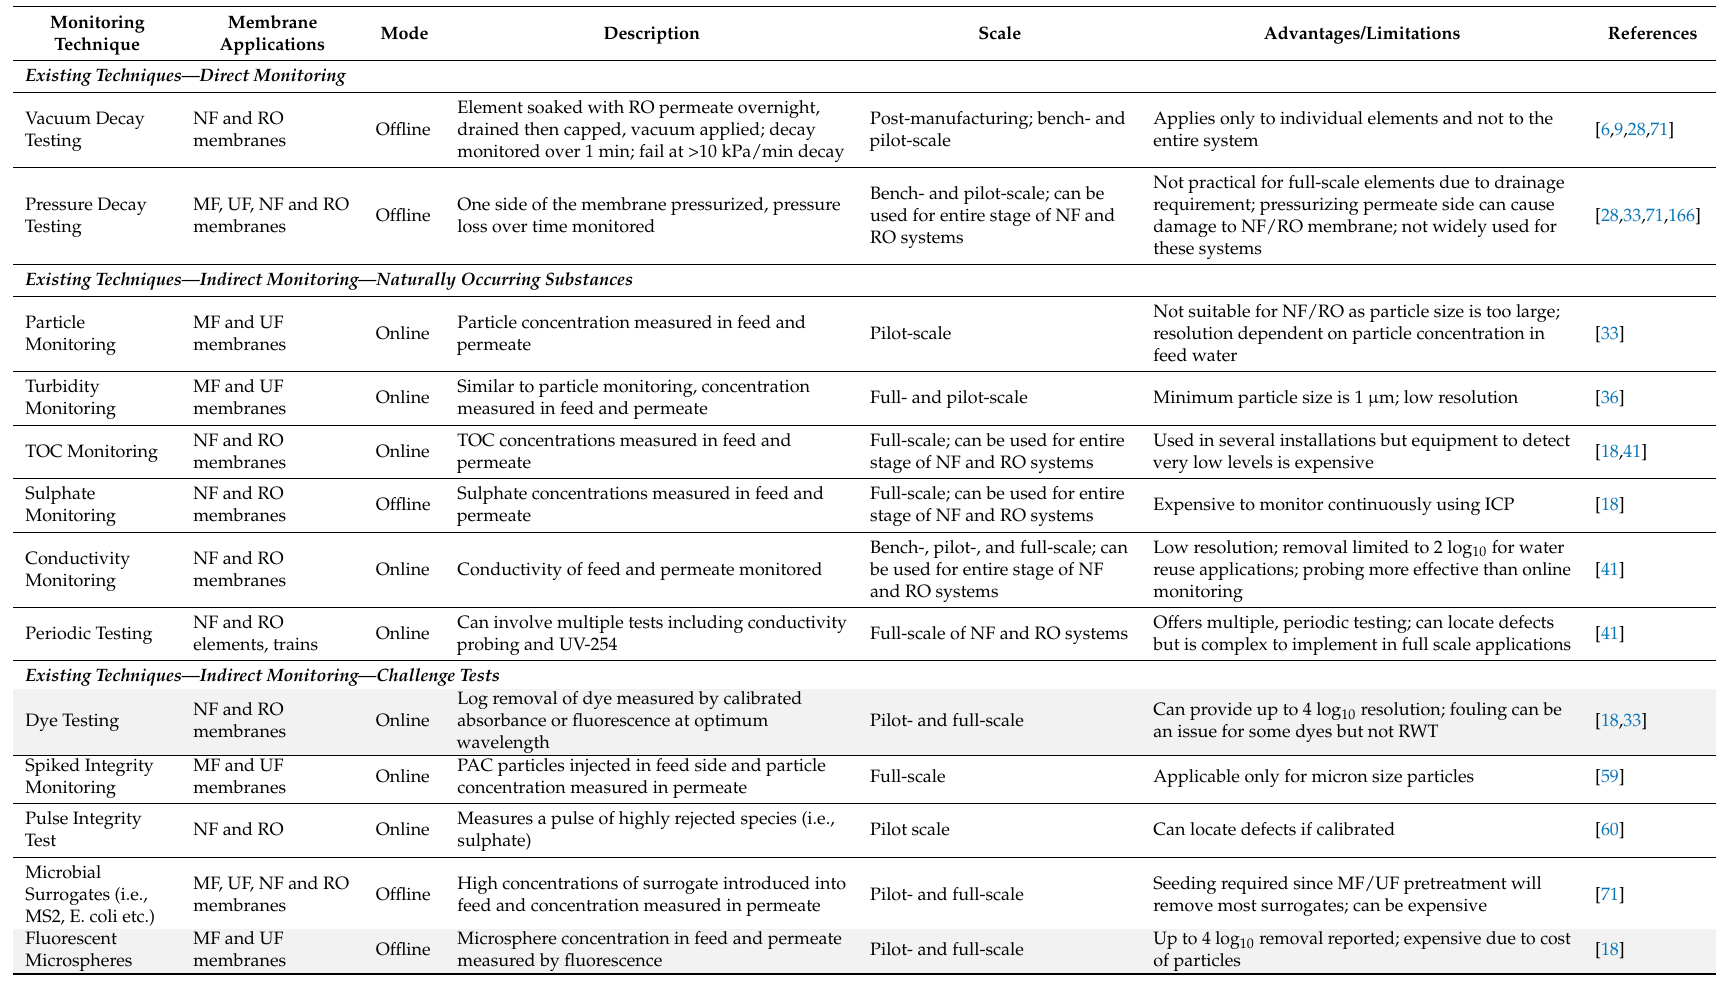
Table 4. Assessment of current and emerging integrity monitoring